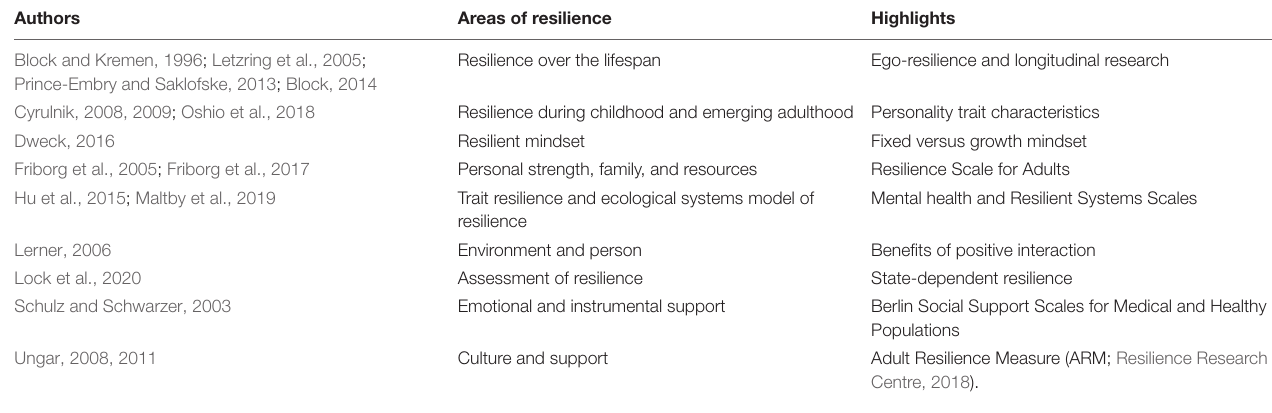
TABLE 1 | Readings for further information on